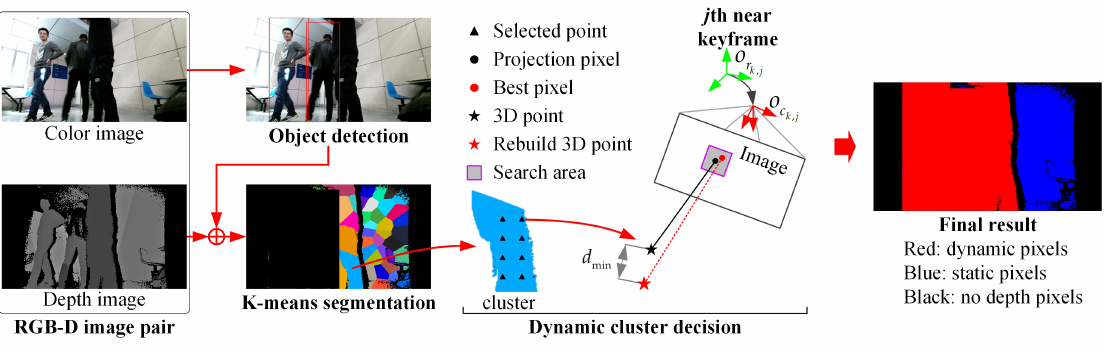
Figure 4. Pipeline of dynamic pixels